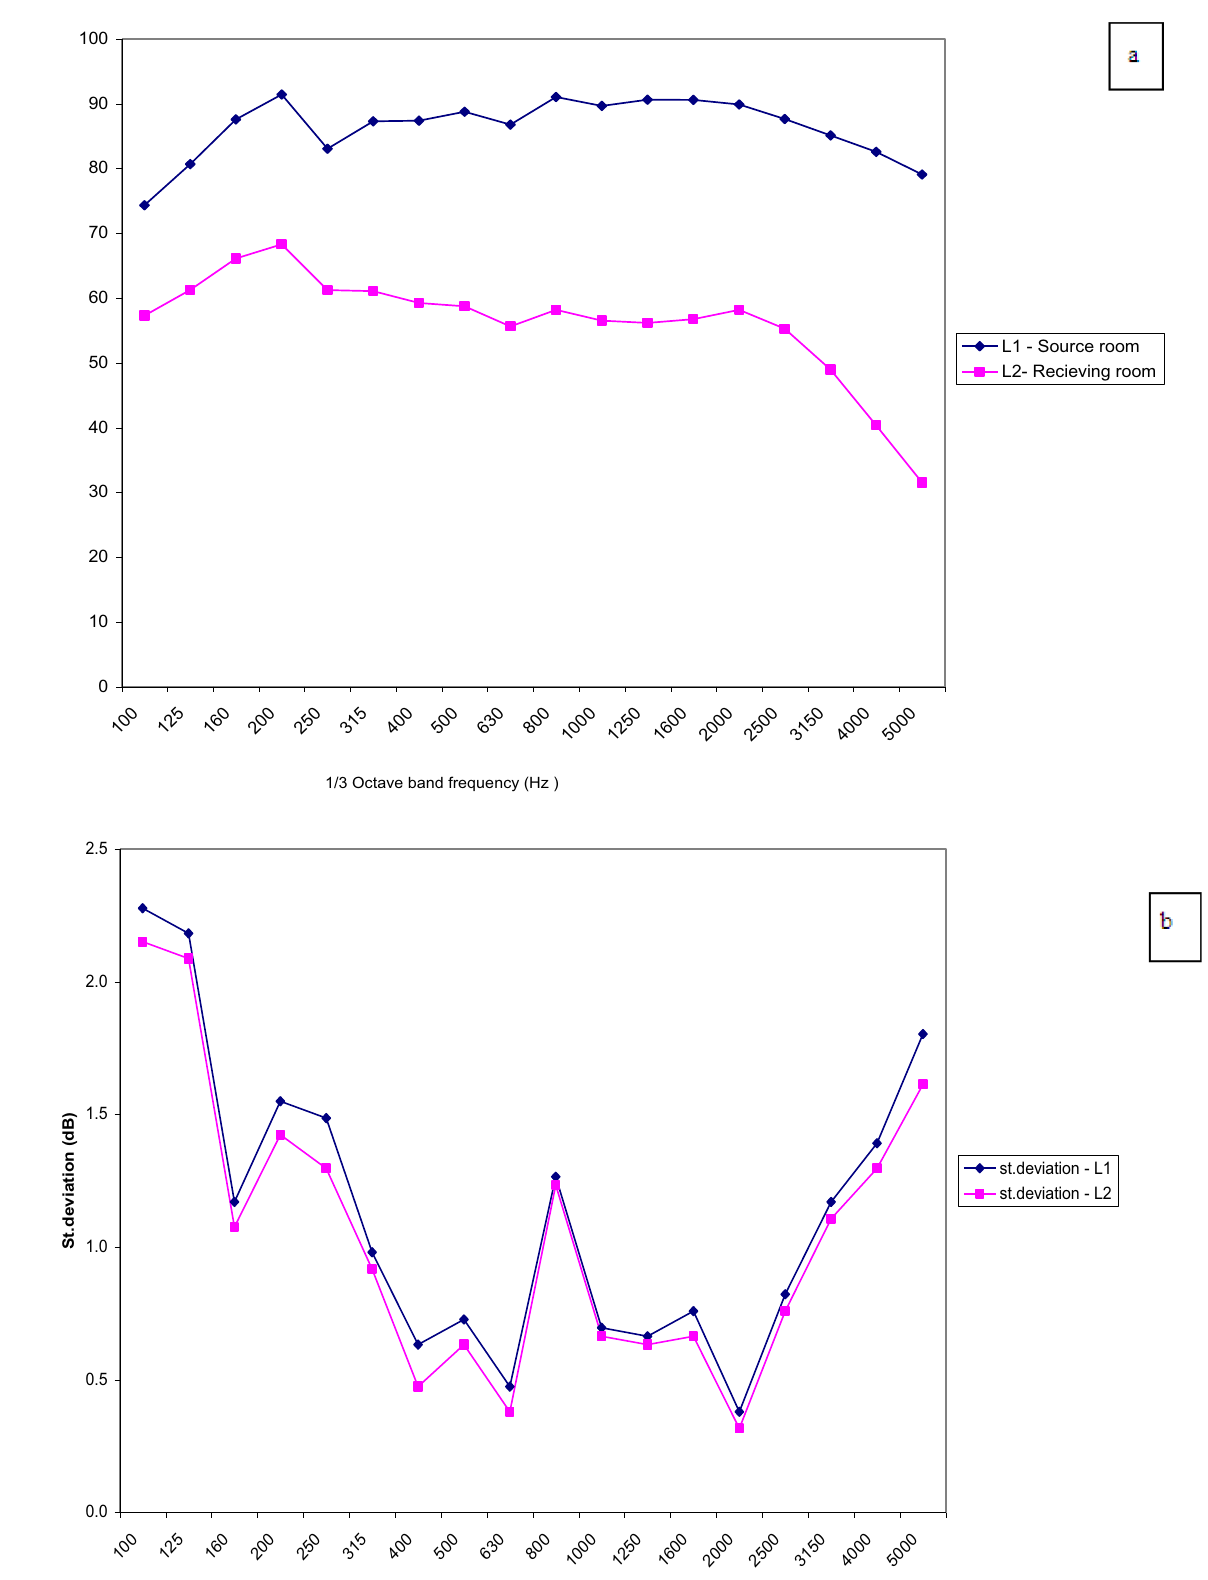
Fig. 4. (a) Average sound pressure levels for L 1 (source room) and L 2 (receiving room), (b) standard deviation for L 1 (source room) and L 2 (receiving